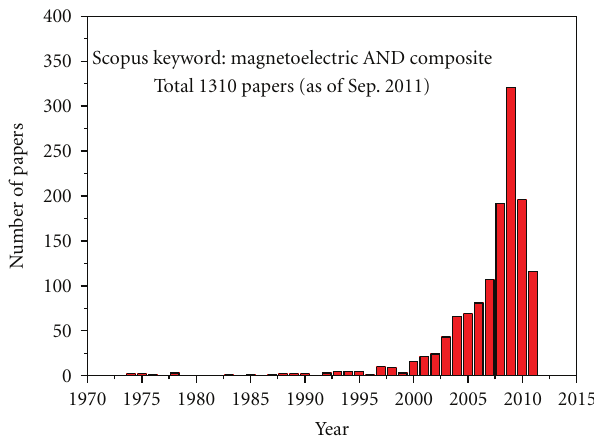
Figure 2: The year wise number of articles published in the literature on the magnetoelectric composite materials.